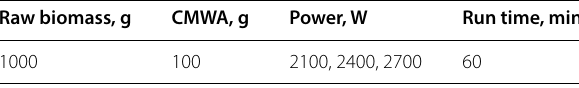
Table 2 Microwave pyrolysis process